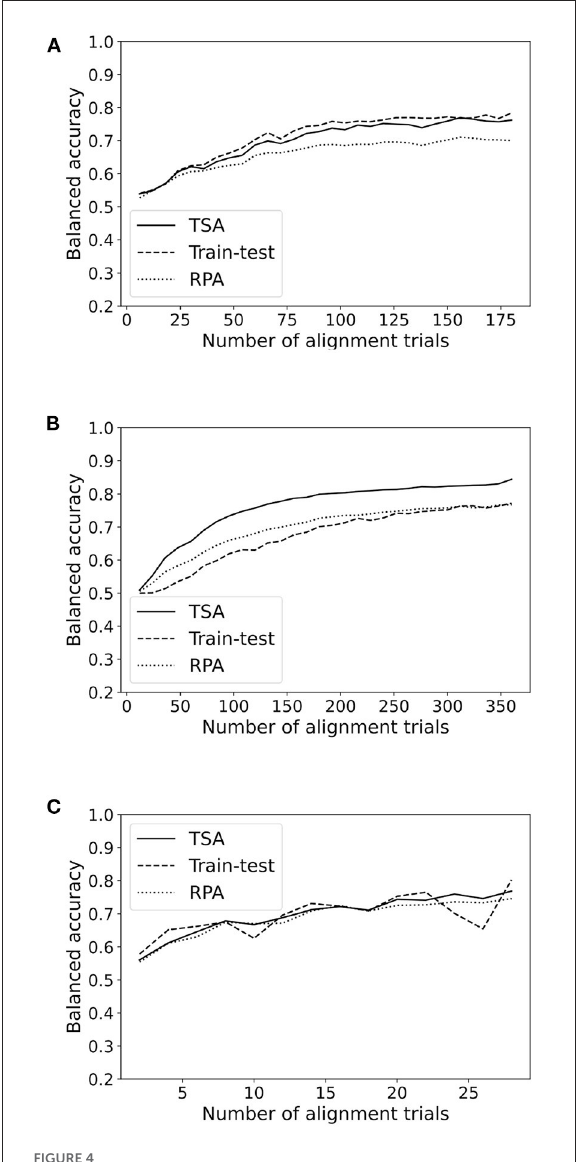
FIGURE4 Accuracy as a function of the number of alignment trials for TSA and RPA methods for a representative database in each paradigm (MI, ERP, SSVEP). (A) Database Cho2017 (MI). (B) Database brain invaders 2013a (ERP). (C) Database SSVEP exoskeleton (SSVEP).